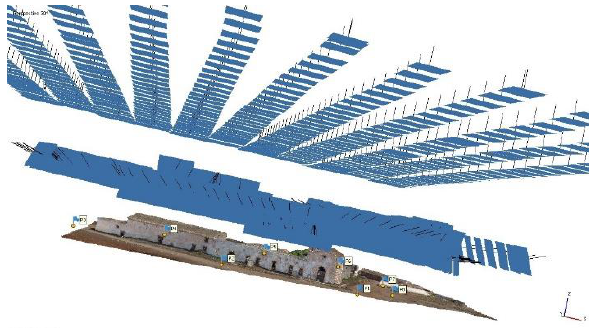
Fig. 5. Camera locations grouped in two flying heights